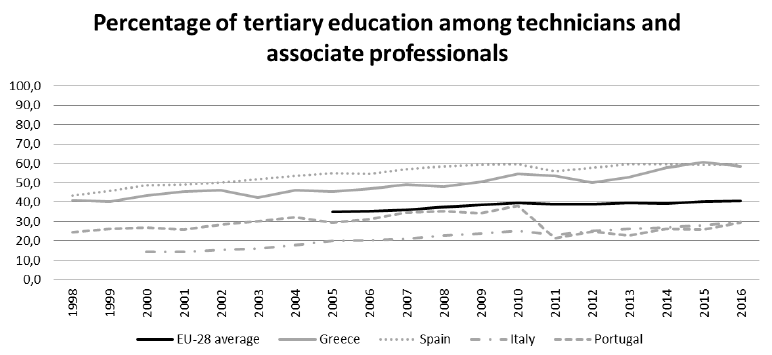
Figure 8: Overall percentage of technicians and associate professionals with tertiary education among employed population 1998-2016